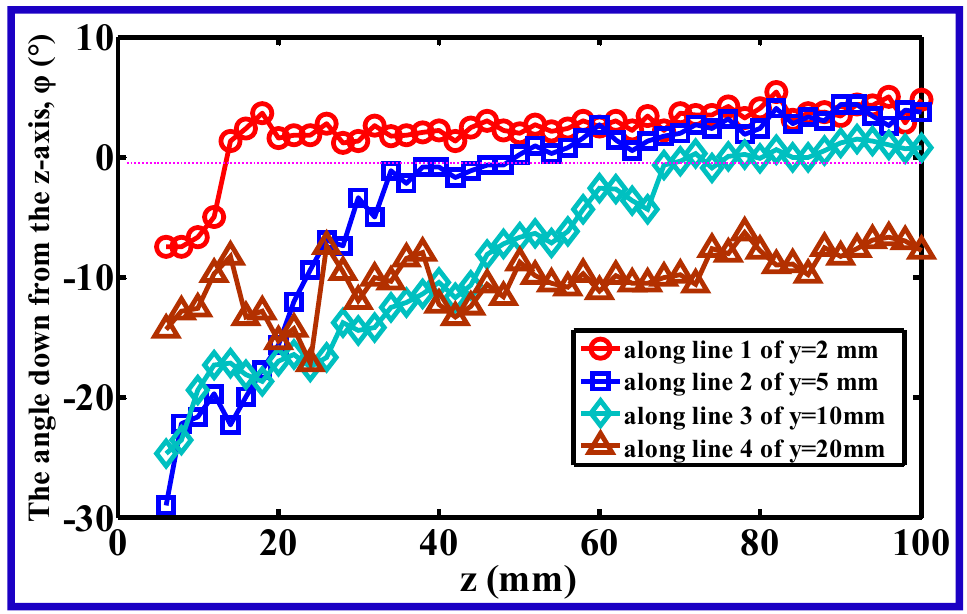
Figure 6. The directional angle between the z -axis and the resultant velocity in the y–z plane at different position along lines 1–4. Lines 1–4 were defined as described in Section 3.2.